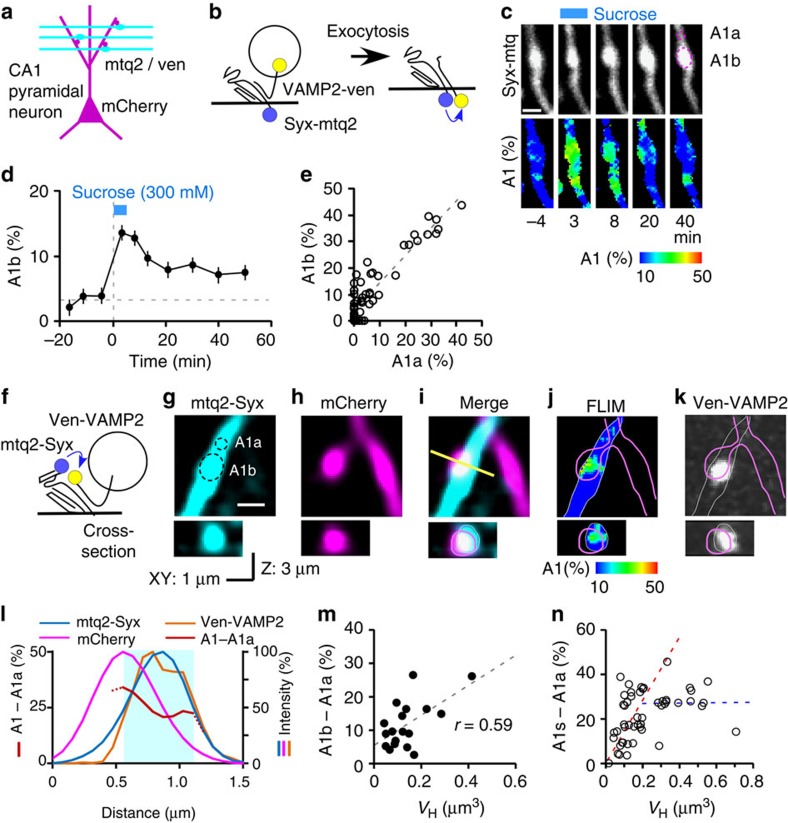
FRET/2pFLIM of presynaptic boutons on the dendritic spines of CA1 pyramidal neurons in slice culture preparations.(a) Schematic drawing of Schaffer collateral fibres on CA1 pyramidal neurons in the stratum radiatum. (b) Schematic drawing of cis-SNARE probes, syntaxin1A-mtq2 (Syx-mtq2) and VAMP2-Ven, which induce FRET after exocytosis. (c) Fluorescence lifetime images of Syx-mtq2/VAMP2-Ven-stained boutons during 300 mM sucrose stimulation (scale bar, 1 μm). (d) Average time courses of the A1 fraction in boutons during sucrose application (24 boutons, 8 axons). (e) The correlation between the A1 fractions in the boutons (A1b) and those of axons surrounding the boutons (A1a; P<0.0001 in Spearman's rank correlation coefficient; r=0.74; n=59). (f) Schematic drawing of the SNARE probes mtq2-Syx and Ven-VAMP2 in the trans-complex. (g,h) Fluorescence images (Z-stacks of three sections) of a Schaffer collateral axon expressing mtq2-Syx (g) and Ven-VAMP2, which were transfected into CA3 neurons using an AAV1, and of dendritic spines expressing mCherry (h) expressed by gene gun (scale bar, 1 μm). These images were simultaneously acquired with the same excitation laser at 900 nm. (i) The overlap of a bouton (g) and spine (h) in both the xy plane (upper panel) and xz plane along the yellow line (lower panel). (j) A lifetime image of mtq2 obtained from the image (g), which shows a high FRET region at the edge of the axonal bouton facing the spine in both xy and xz images. (k) A fluorescence image of Ven-VAMP2 obtained from the same area at 980 nm, where the precise location of Ven-VAMP2 relative to the dendrite was aligned by simultaneous imaging of Ven-VAMP2 and mCherry. (l) The fluorescence profiles along the yellow line in i for mtq2-Syx, Ven-VAMP2, mCherry and A1-A1a fractions of mtq lifetime images. The cyan-shaded region represents the axonal area where the fluorescent intensity of mtq-Syx was 50% of the peak value. (m) The correlation between spine volume (VH) and A1b–A1a. Spearman's rank correlation coefficients were r=0.59 (P=0.008, n=19). (n) The correlation between spine volume (VH) and the peak A1b value at the point facing the spine (A1s–A1a, n). In addition to the data points in (m), we intentionally sampled more spines from larger spines. Spearman's rank correlations was 0.45 (P=0.0095, n=32, the red dashed line) for spines with volumes <0.2 μm2, while −0.067 (P=0.86, n=18, the blue horizontal dashed line) for spines with volume >0.2 μm2. The average A1s–A1a values for spines with volumes >0.25 μm2 was 27.7±2.1% (n=16).